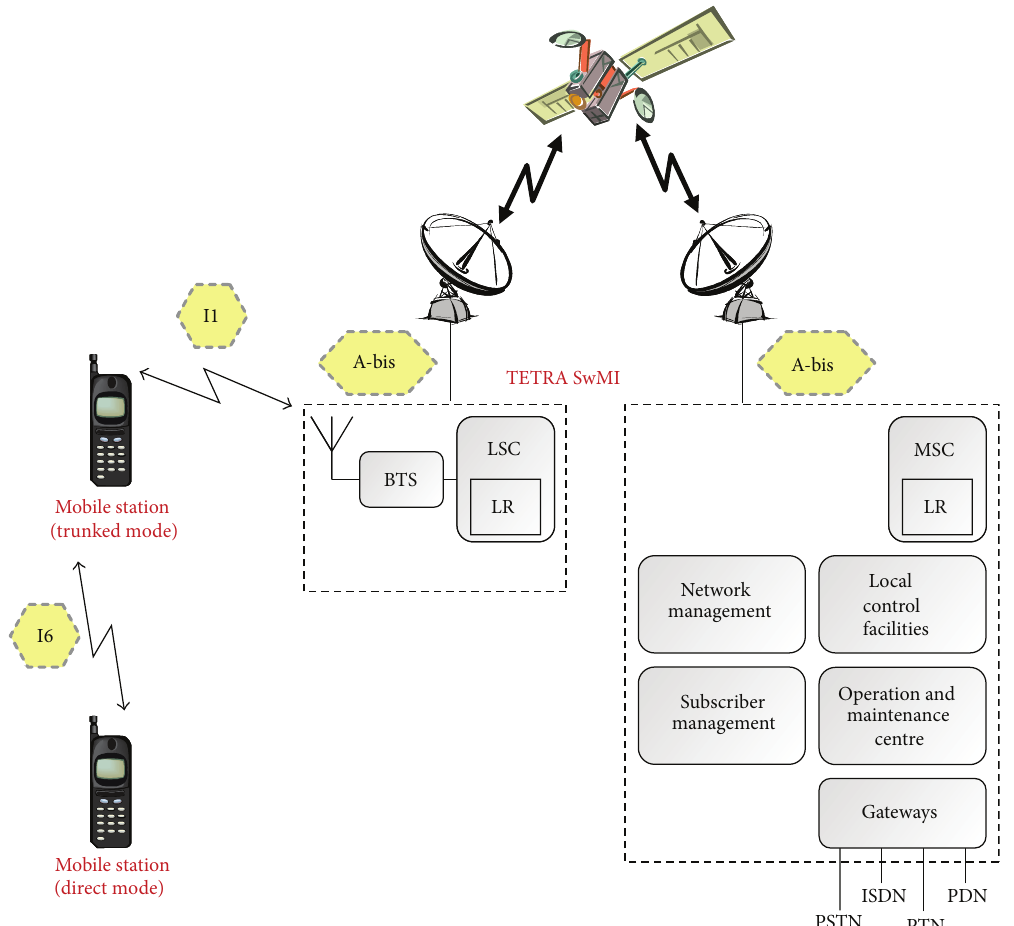
Figure 3: A-bis-based TETRA backhauling via